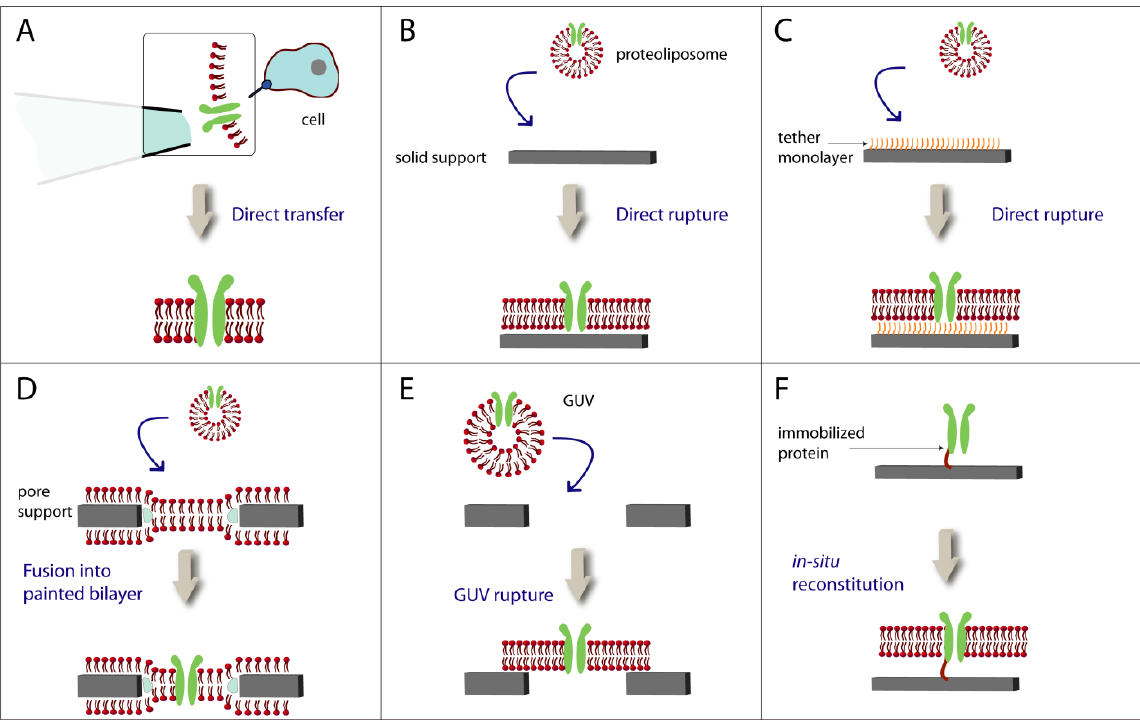
Figure 3. Protein integration